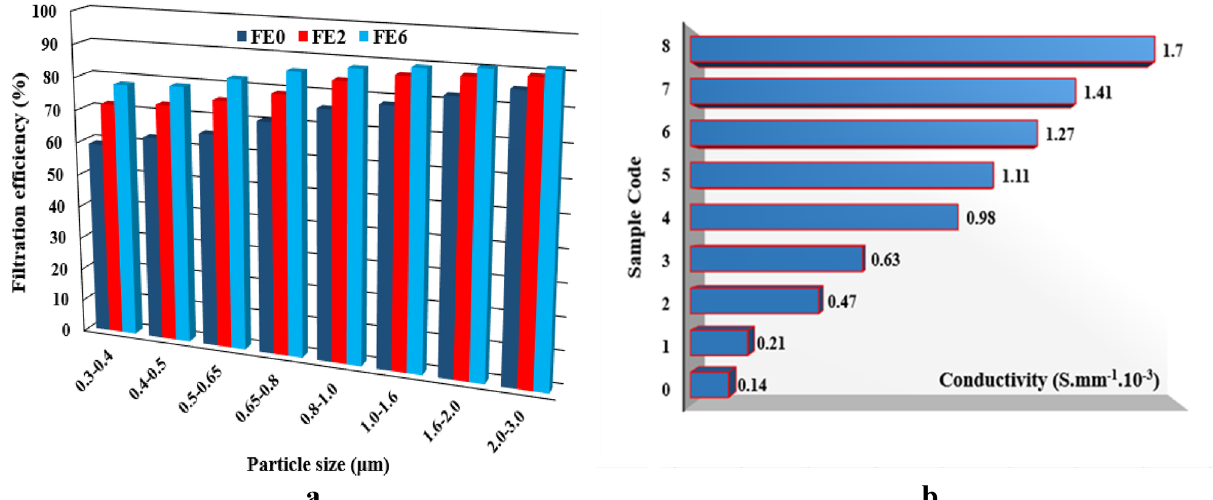
Figure 6. The FE of the coated samples against particles of different sizes ( a ) and the electrical conductivity of the fabrics ( b ). Sample 0 (Uncoated fabric), Samples 1–4 and 5–8 (NS-coated fabrics at 2, 10, 20, and 50 mM silver nitrate concentrations, and 25 and 50 min sonication time,